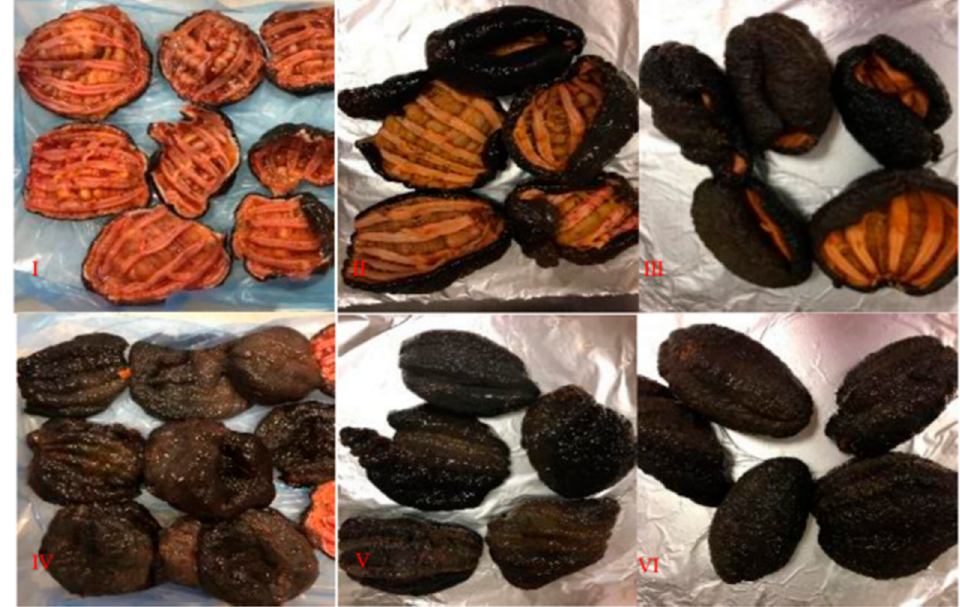
Figure 5. Dermis of C. frondosa (( I – III ) represent the raw, boiled, and steamed samples on the ventral side, ( IV – VI ) represent them on the dorsal side). Table 1. Texture of C. frondosa after various heating treatments. Different letters (a, b, c, d, e, f, g, h) indicate significant differences between groups as determined via one-way ANOVA ( p < 0.05).